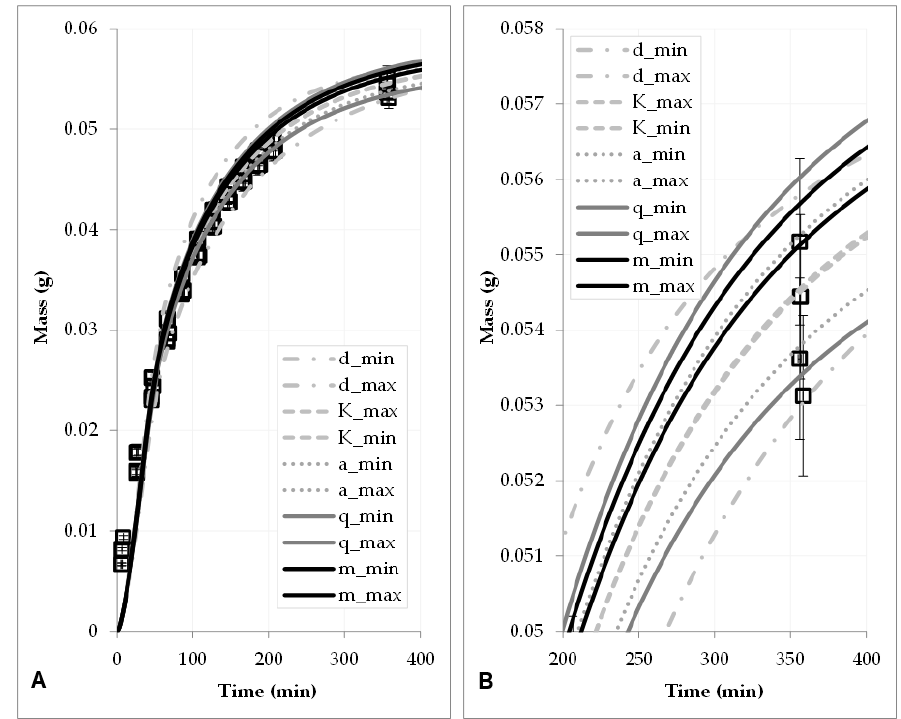
Figure 7. Sensitivity analysis one-parameter-at-a-time. ( A ) whole extraction; ( B ) zoom to the last data point (highest mass of extracted components).